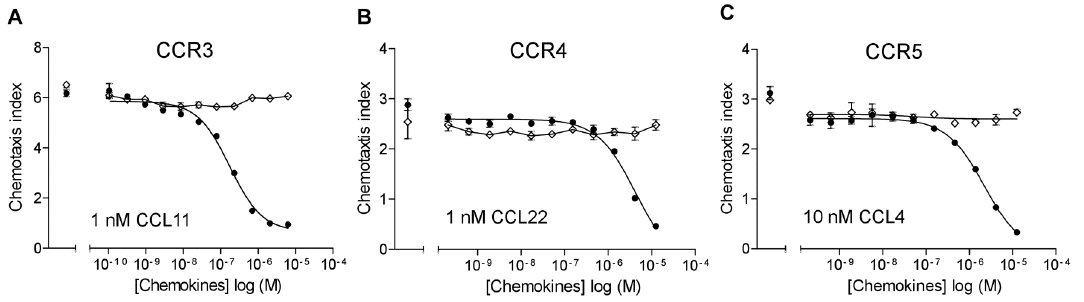
Figure 6. The 44 KRGR 47 cluster of CCL18 in the 40’s loop is involved in the interaction with CCR3, CCR4 and CCR5. A) L1.2/CCR3 transfectants migrating to 1 nM CCL11 was inhibited by CCL18-6His (●) (IC migrating to 1 nM CCL17 was inhibited in the presence of CCL18-6His (IC CCR5 transfectants induced by 10 nM CCL4 with an IC CCL18-6His (◊). One representative experiment out of two is shown.